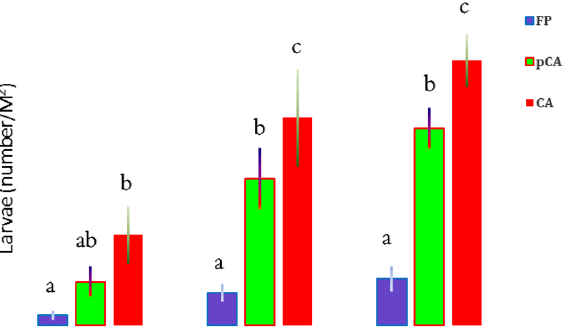
Figure 3. Mean infestation of Mythimna separata larvae on wheat in different tillage-cum crop establishment and residue management practices at 65 DAS during recent different years. Bars with different letters indicate significant differences among agricultural production systems (LSD; P < 0.05).